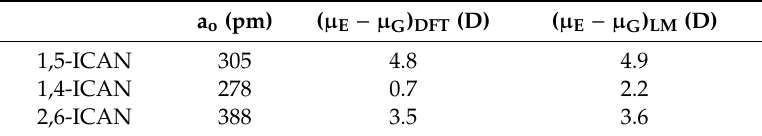
Table 3. The Onsager-radius (a o ), dipole moment difference between the excited and the ground state (( µ E − µ G ) DFT ) calculated by DFT (in DMSO, the values in hexane are ~0.4 D lower), and the dipole moment differences in the excited and ground state (( µ E − µ G ) LM ) determined by the Lippert–Mataga